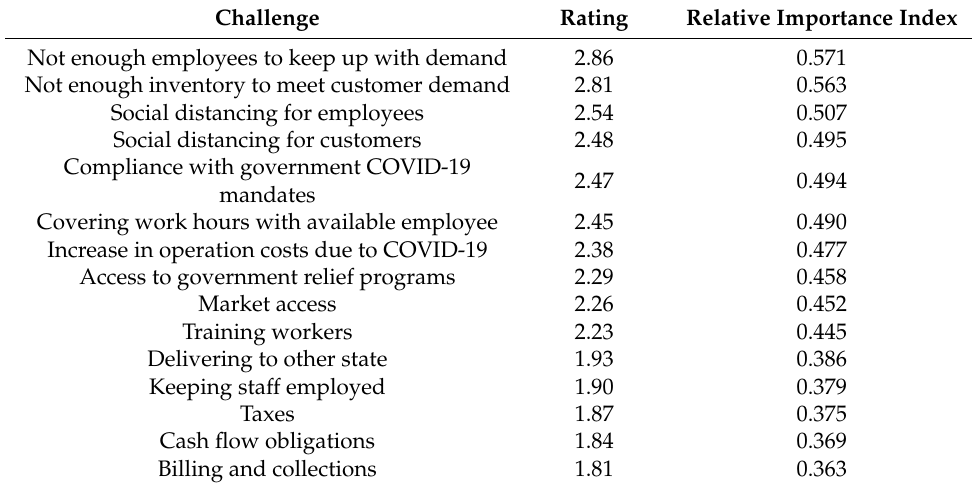
Table 4. Severity of challenges faced by businesses due to the pandemic on a scale of 1 to 5 (1 = not challenging at all, 2 = slightly challenging, 3 = challenging but manageable, 4 = definitely challenging, 5 = very